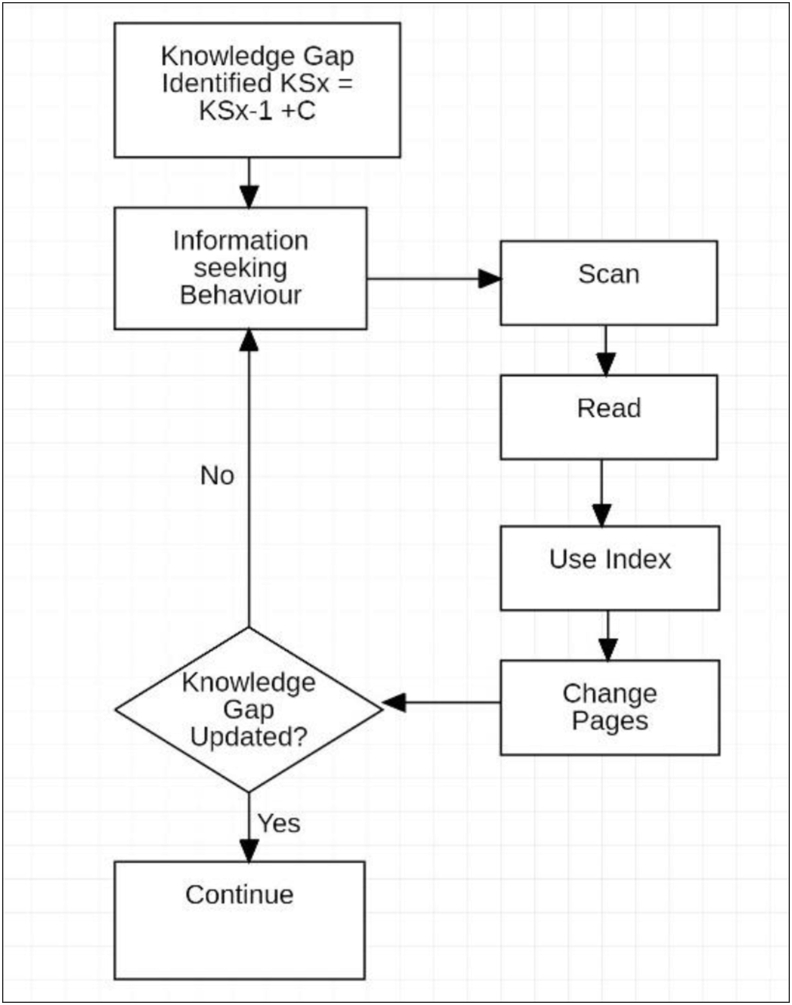
Learning flowchart.